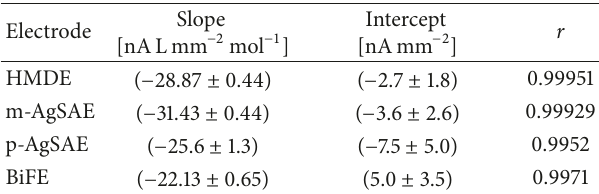
(DPV, BRB DAN =+200mV, 𝐸 = − 1300mV, in fin